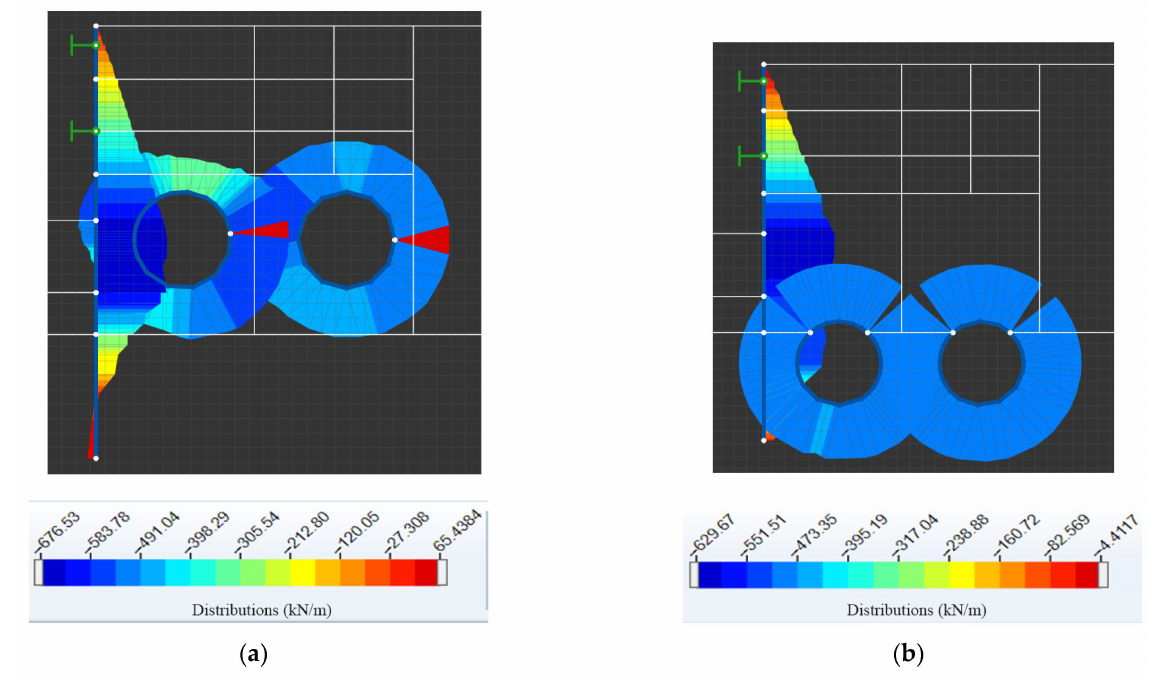
Figure 24. Axial force diagram under different cover depth C of the twin shield tunnels in stage (3):